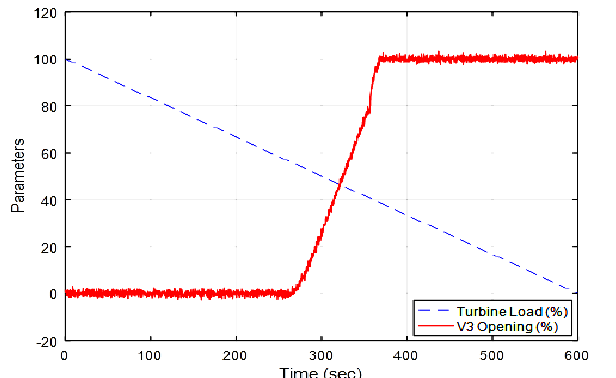
Fig. 11. Steam dump valve-2 actuation with turbine load at first vertex of polytope